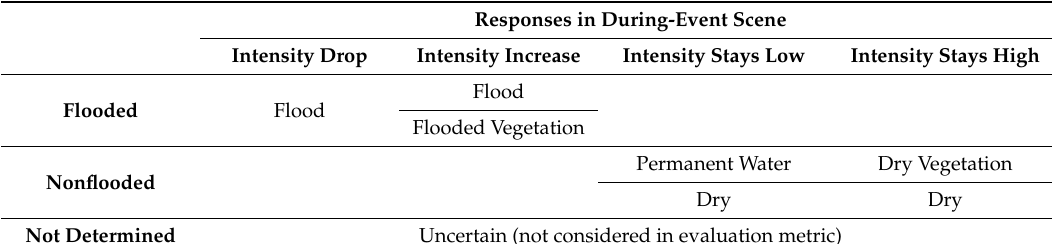
Table 1. Classes in the validation dataset and their backscattering